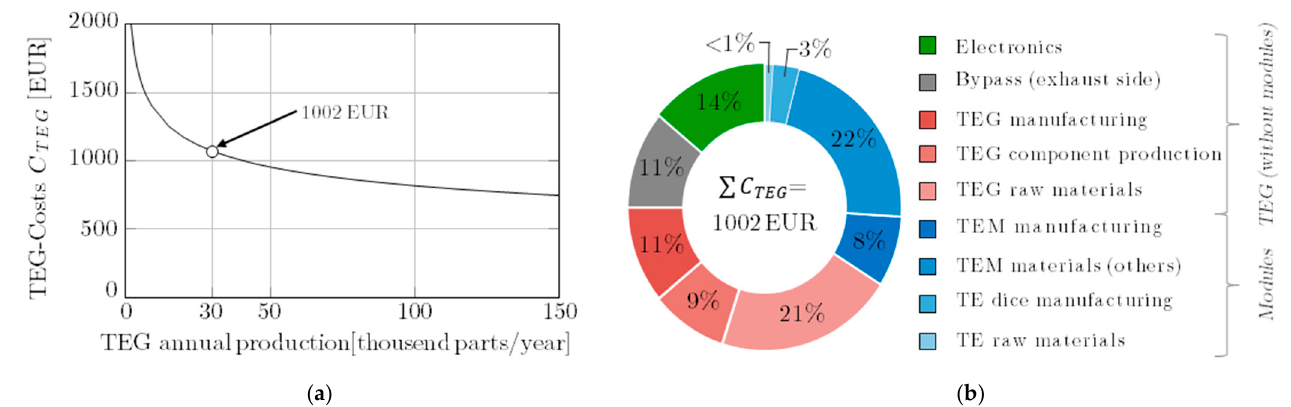
Figure 6. TEG cost model. ( a ) TEG costs by economics of scale. ( b ) Cost breakdown of the TEG design TCO min .